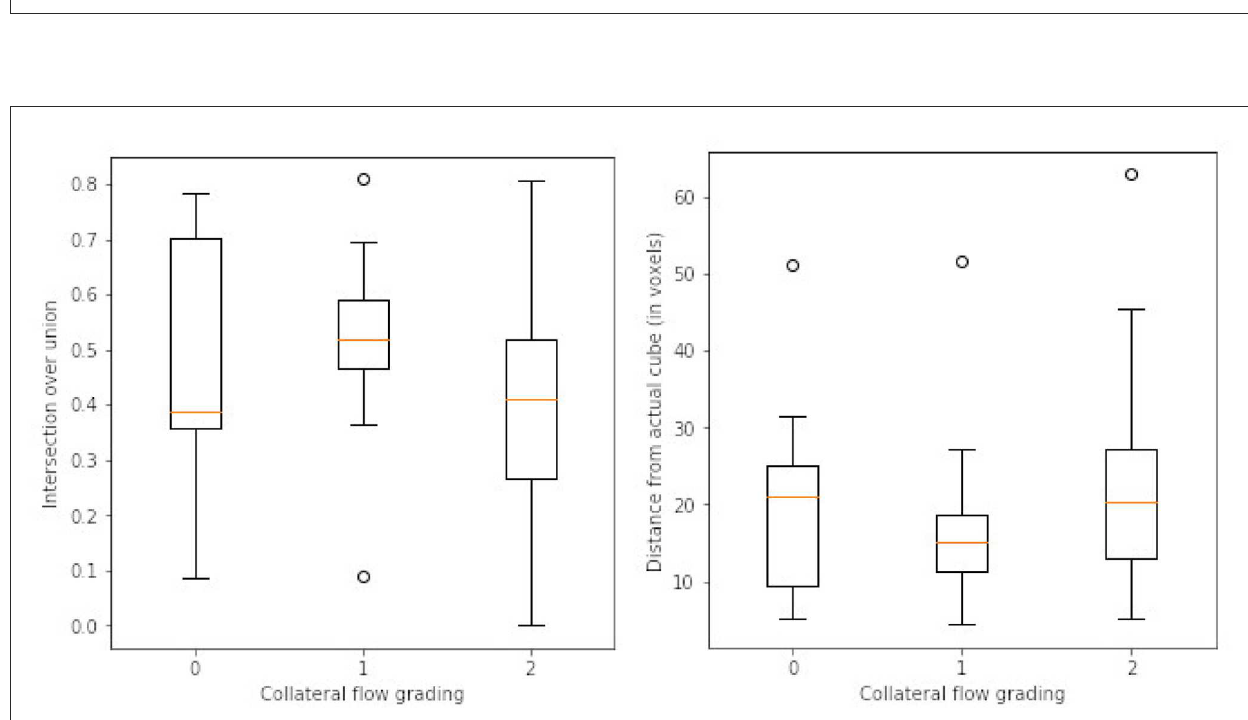
FIGURE5 Box plots of results from ROI detection task. Left is the intersection over union (IoU) ratio between the prediction and the ground truth over the three classes. Right is the euclidean distance between the predicted center point and the ground truth center point. From the distributions, it is clear that it is easy to detect the ROI in the poor collateral flow class (class 0) compared to the good collateral flow class (class 2). This can be explained by the fact that in good collateral flow cases T max shows uniform values in the whole